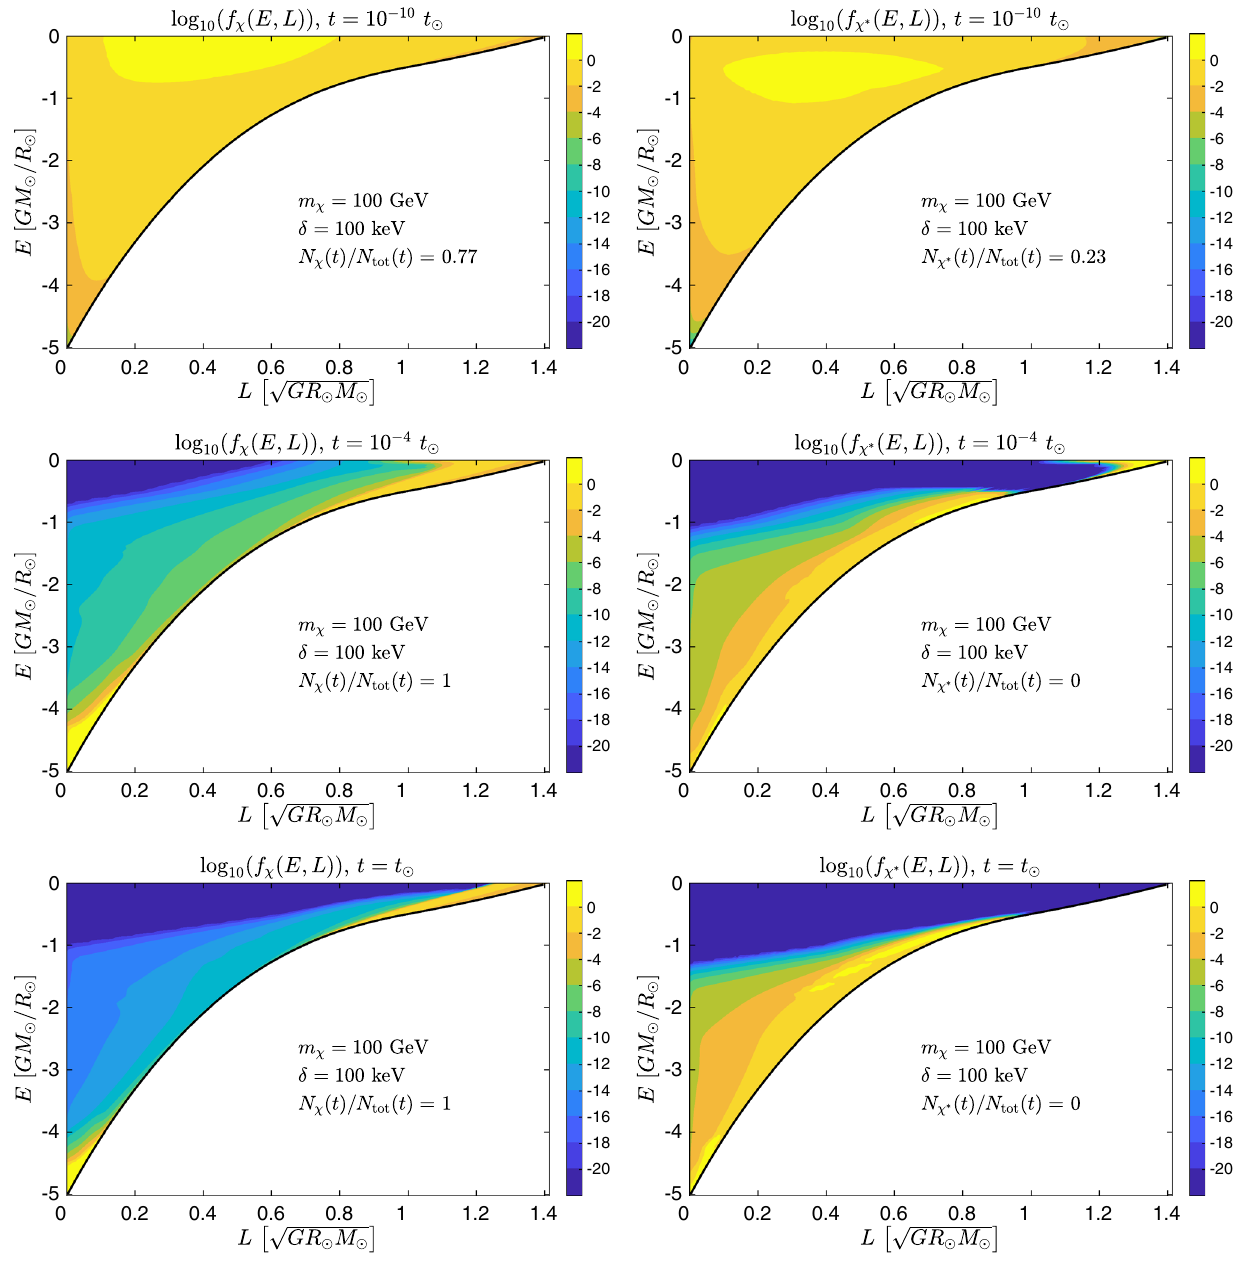
Fig. 6 The base 10 logarithm of the distribution of DM at various times with an initial distribution given by the capture rate. We use m χ = 100 GeV and δ = 100 keV. Left column: χ distribution. Right column: χ ∗